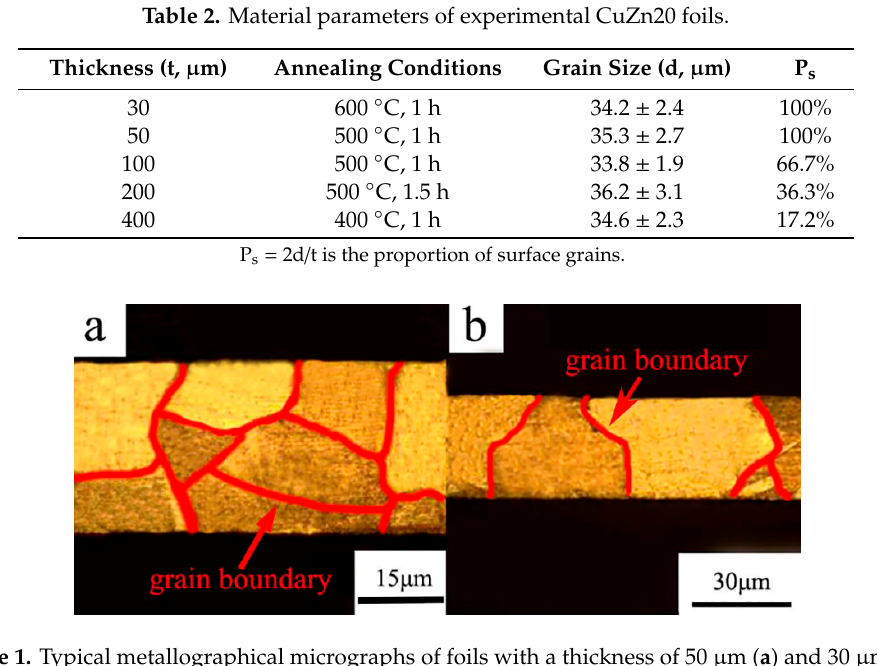
Figure 1. Typical metallographical micrographs of foils with a thickness of 50 μ m ( a ) and 30 μ m ( b ).